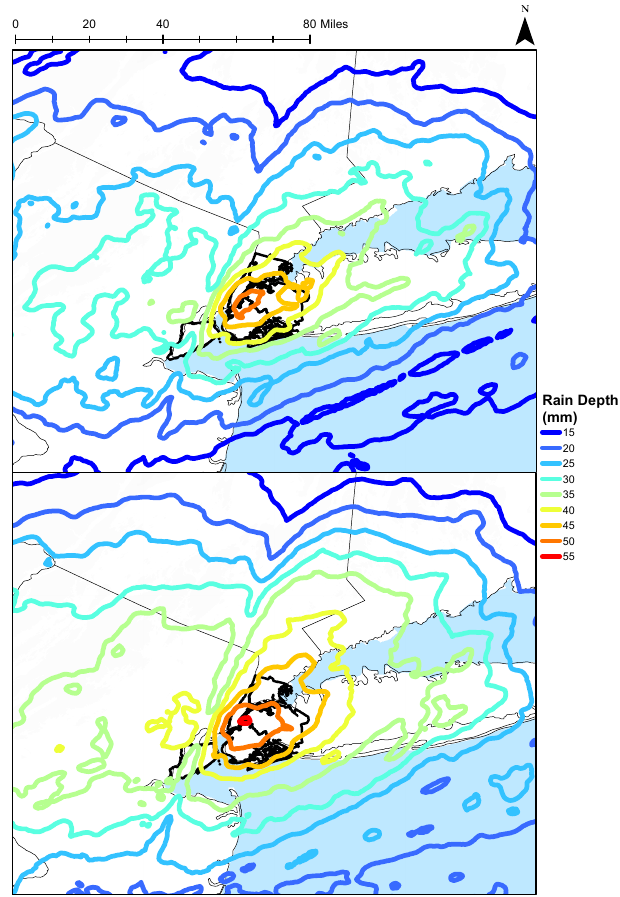
Figure 5. Rainfall depth for daily-averaged rainfall for the 50 rainiest days in NYC ( top ) and the days with the highest 3-h rainfall in NYC ( bottom ). Bold black lines represent NYC borough boundaries, white areas represent land masses, and blue areas represent water